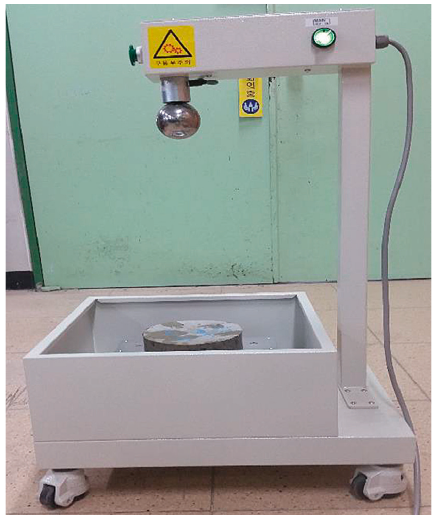
Figure 5: Impact resistance test setup.